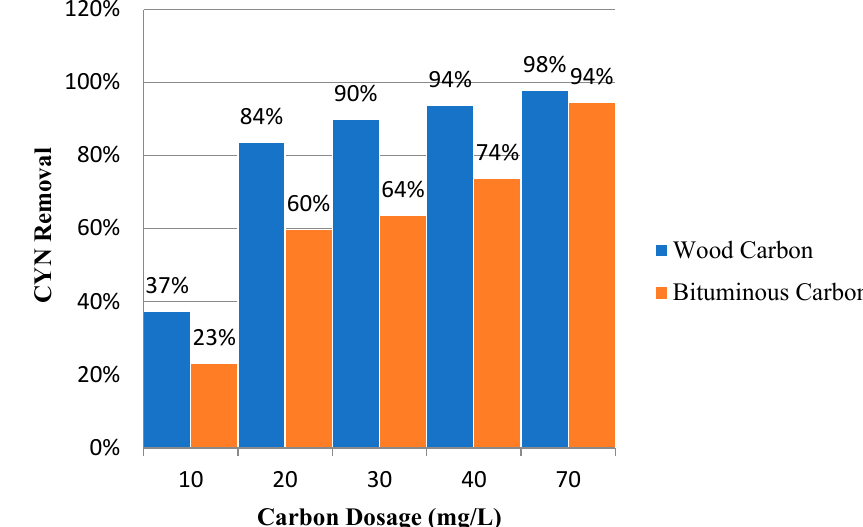
Figure 7. CYN removal as a function of the applied carbon concentration in Paranoá lake water matrix (C0—Bituminous Carbon = 102.23 μ g/L; C0—Wood Carbon = 89.24 μ g/L); initial pH of the study water = 6.5. Base water: pH = 7.7; Turbidity = 0.07 uT.